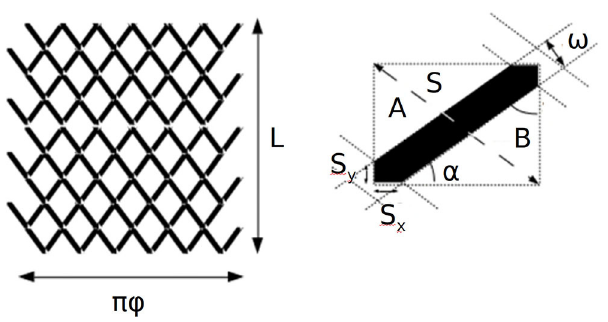
FIGURE 3 | Four sample cases, one for each FD brand used. The first column presents the XA with contrast dilution and the FD. Second column presents the FD highlighted in red. Third column shows the 3D representation of the angiography with the simulated stent implanted at the same distal location as the actual FD. Fourth column shows a close-up of the simulated FD model labeled by porosity. FD,